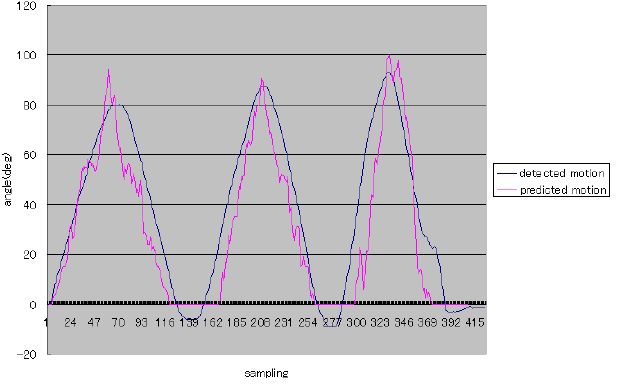
Figure 16. The typical elbow flexion and extension for Subject 1.